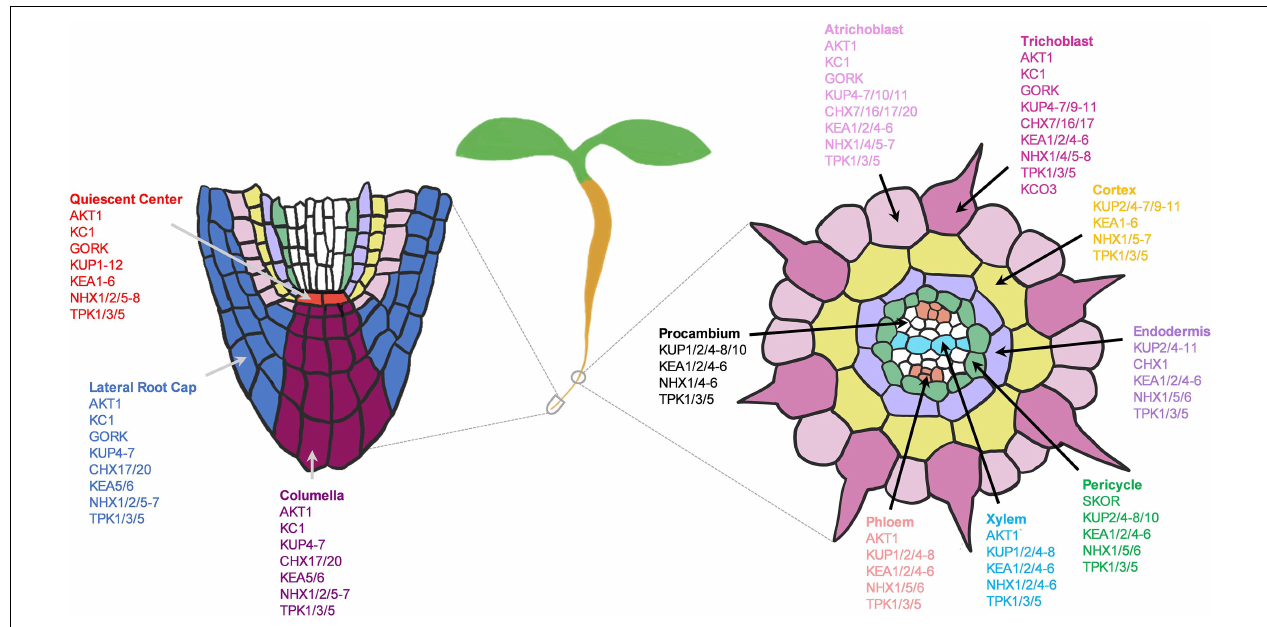
FIGURE 13 | Potential network of potassium (K + ) channels and transporters in the root system of 5–7 days old Arabidopsis seedlings grown under the normal growth conditions. Expressed K + transporters involved in longitudinal transport (left) at the meristematic zone and radial transport (right) at the elongation/maturation zones were shown. K + transporter genes not expressed under the normal growth conditions were